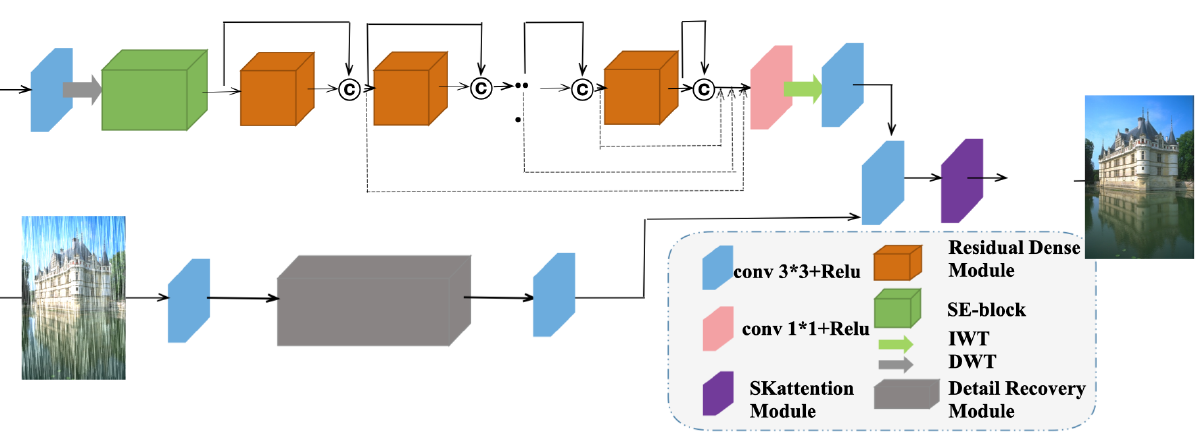
Figure 3. Diagram of the proposed